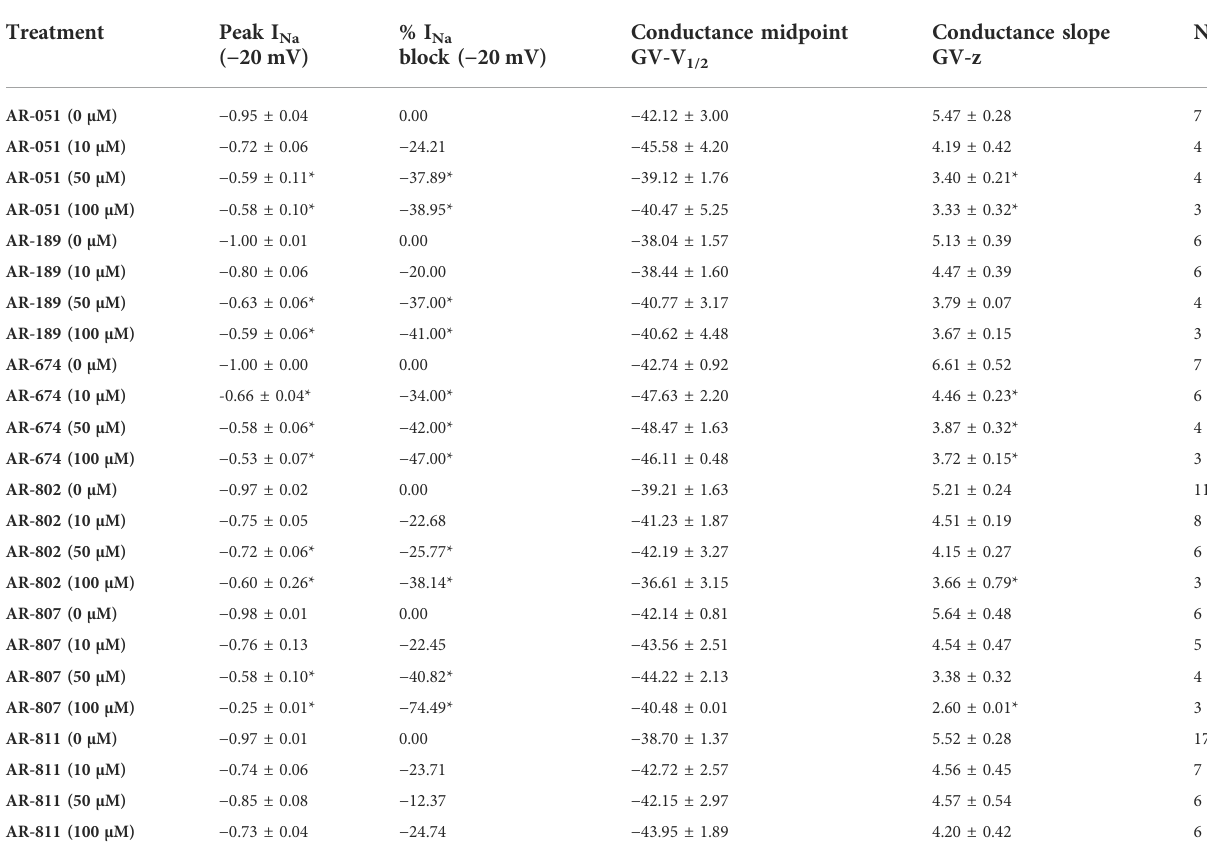
TABLE 3 Peak I NA and Conductance.